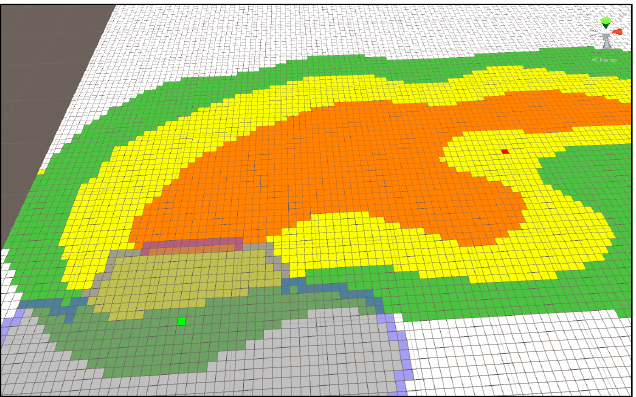
Figure 17. Search process of multi-extra.